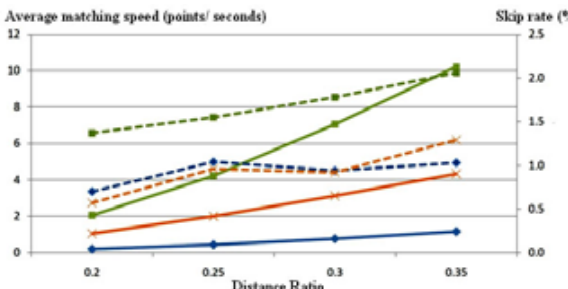
Table 4. Computational efficiency of AFTP and QF